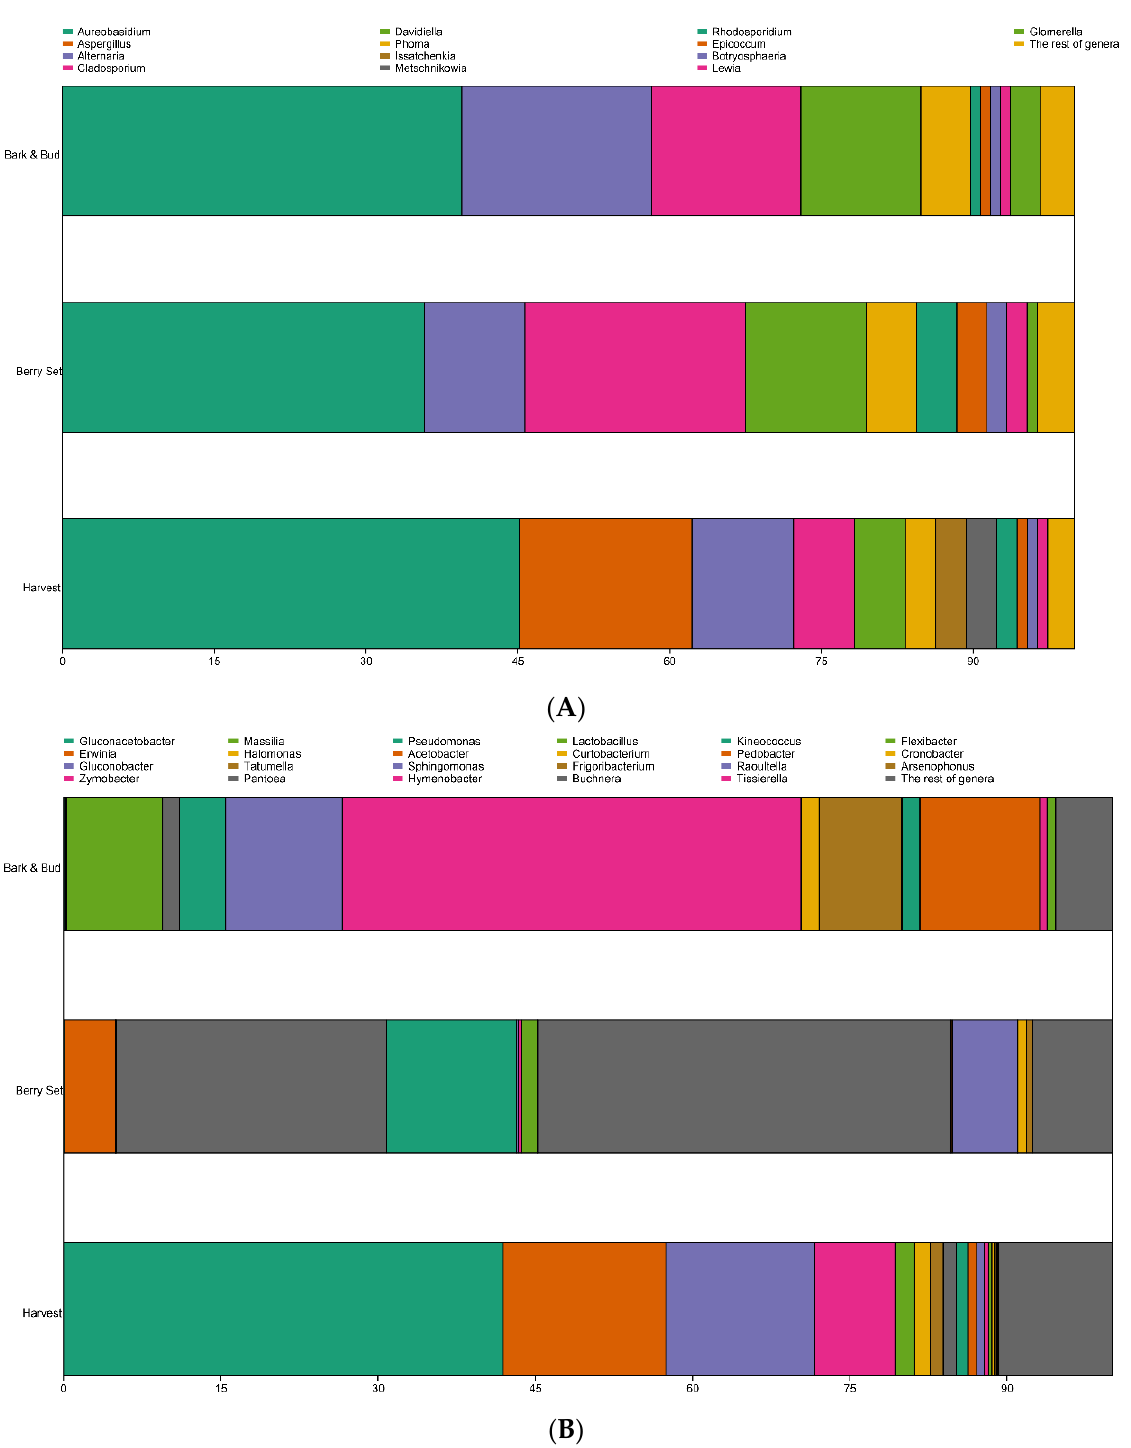
Figure 2. The relative abundance of the dominant (A) fungal and (B) genera among the three phenological stages. Table 2. Relative abundance of (A) fungal and (B) bacterial genera with their percentages detected among the three phenological stages.